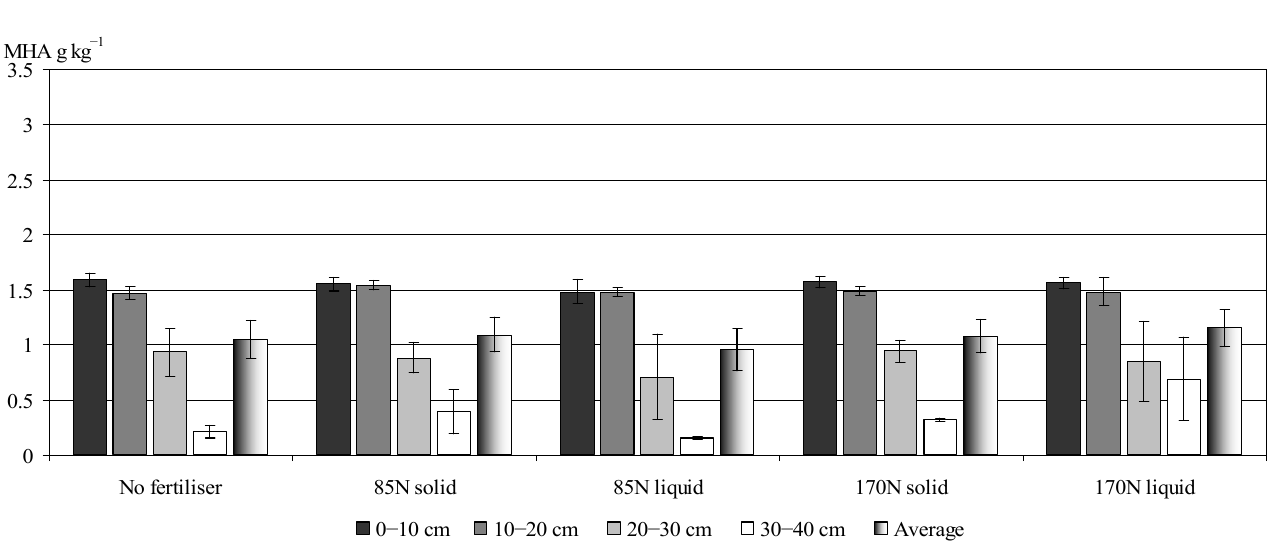
Figure 10. MHS content in the crop rotation field in Fluvisol, 2020.